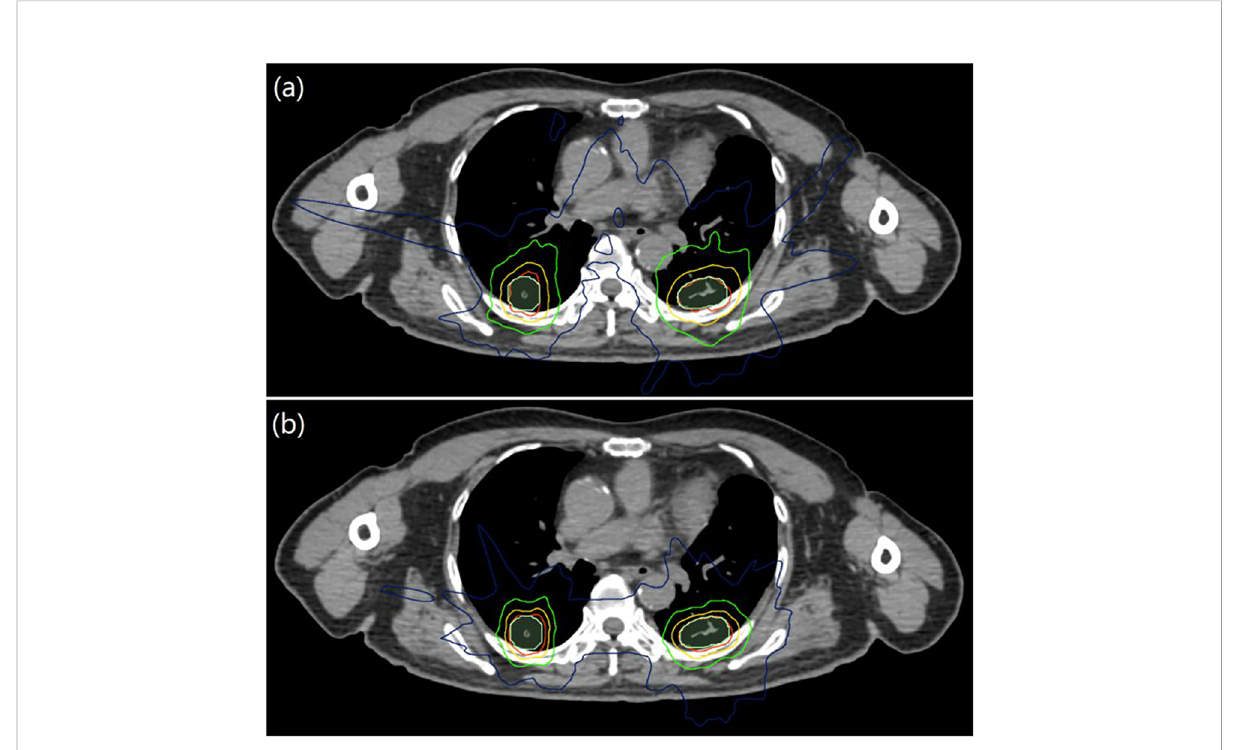
FIGURE 1 Transverse section isodose distributions for Plan S and Plan D of synchronous bilateral lung cancer, (A) was Plan S, (B) was Plan D; PTV was represented by light green area, and the red, yellow, green and blue lines were isodose lines of 50, 40, 25 and 10 Gy,